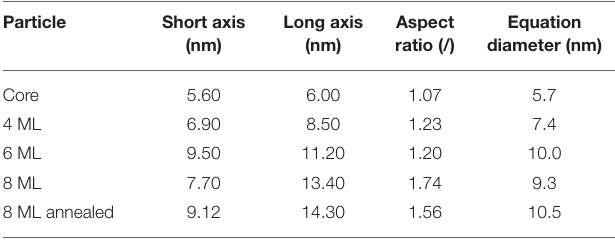
TABLE 2 | The size parameters of the retrieved 3 dimensional dummy atom models for the large core